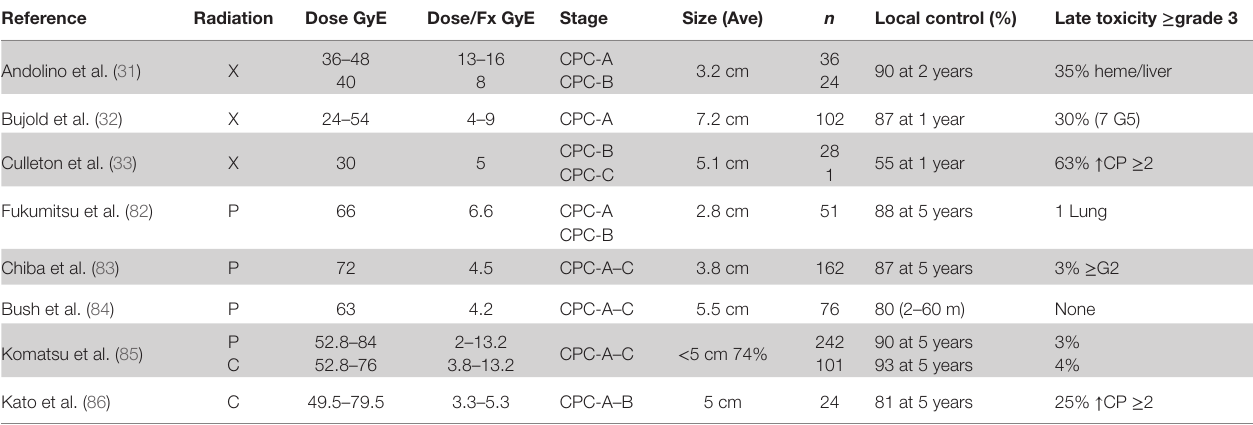
TABLe 3 | Hepatocellular